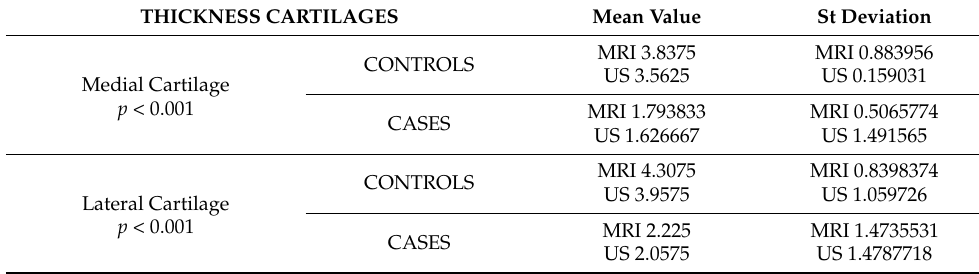
Table 3. Student’s t -test. Thickness of Throclear Cartilages. Student’s t -test used to compare the media values of the thickness of trochlear cartilages examined by US and MRI in cases and controls. The difference in media values of medial and lateral trochlear cartilages in cases and controls is statistically significant using Student’s t -test. applied in both MRI and ECO. MRI (Media cases = 1.79 ± 0.50 mm; media controls = 3.83 ± 0.88 mm). US (Media cases = 1.62 ± 0.52 mm; media controls = 3.56 ± 1.0 mm). MRI (Media cases = 2.2 ± 0.47 mm; media controls = 4.3 ± 0.83 mm). US (Media cases = 2.0 ± 0.47 mm; media controls= 3.9 ± 1.0 mm). THICKNESS CARTILAGES Mean Value St Deviation Medial Cartilage p <